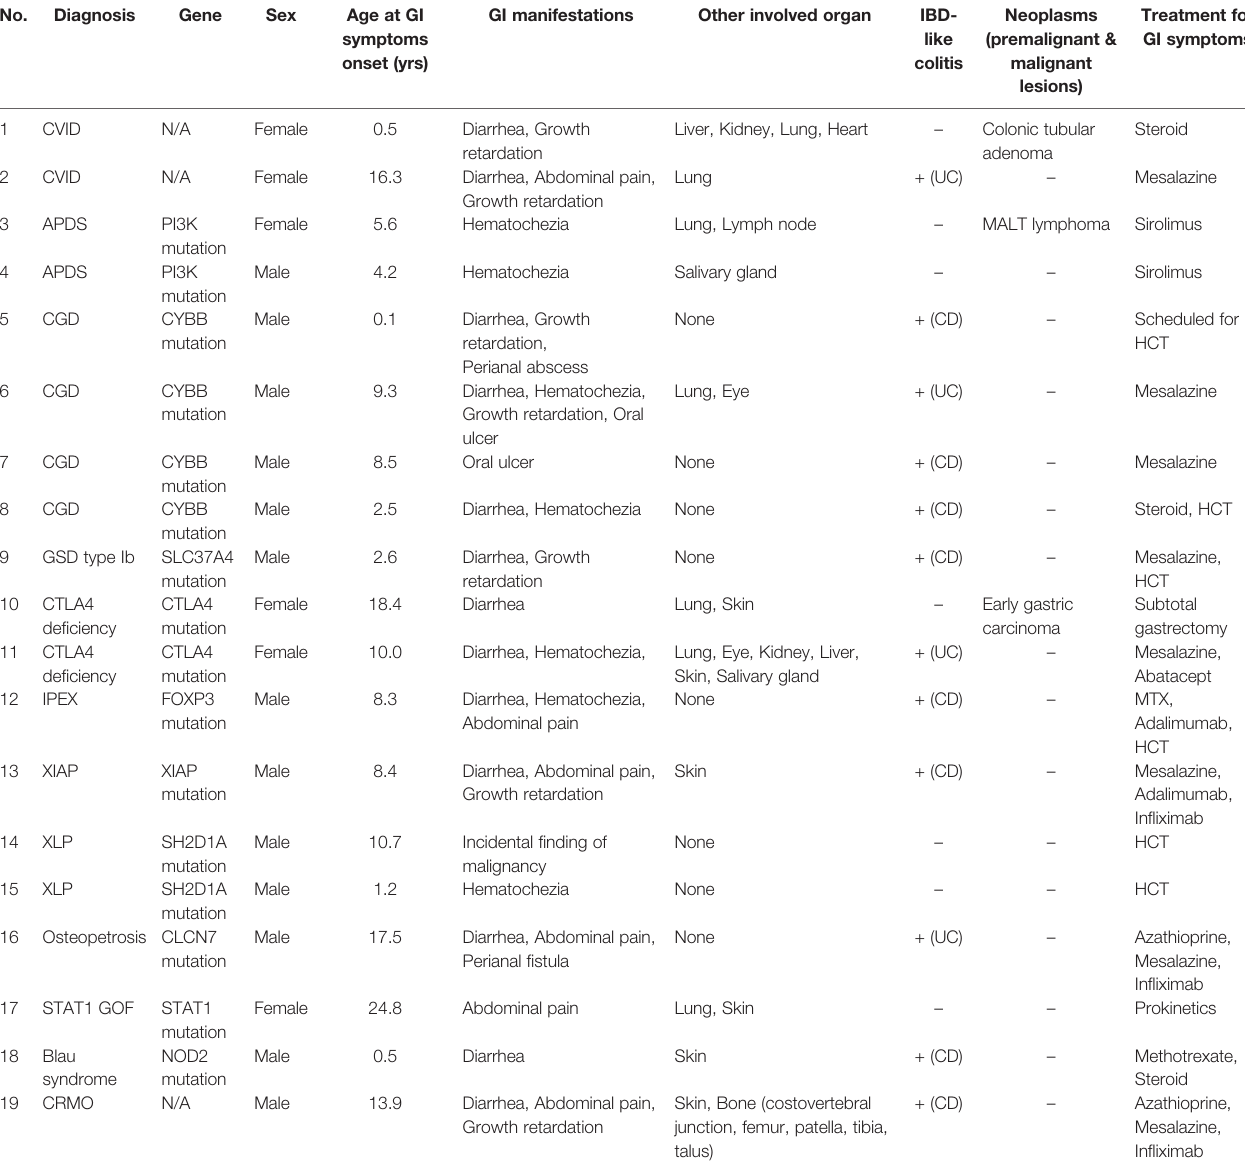
TABLE 3 | Clinical characteristics of 19 patients diagnosed with inborn errors of immunity who required endoscopic evaluations.